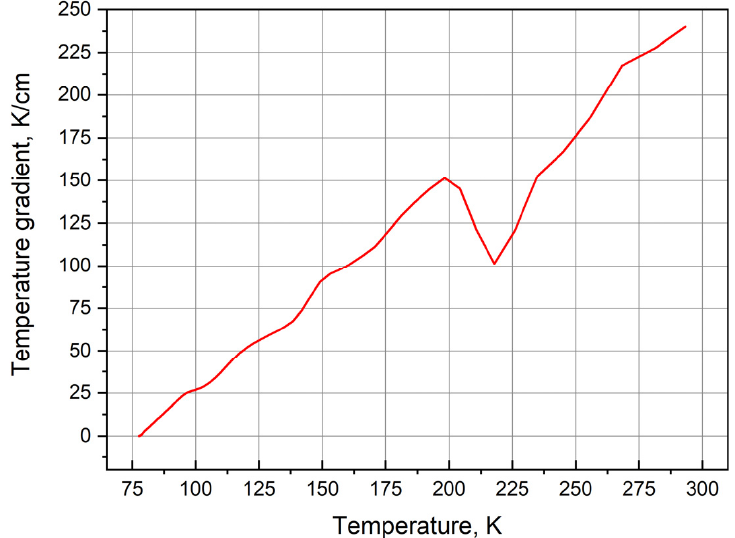
Figure 8. Temperature dependence of temperature gradient.